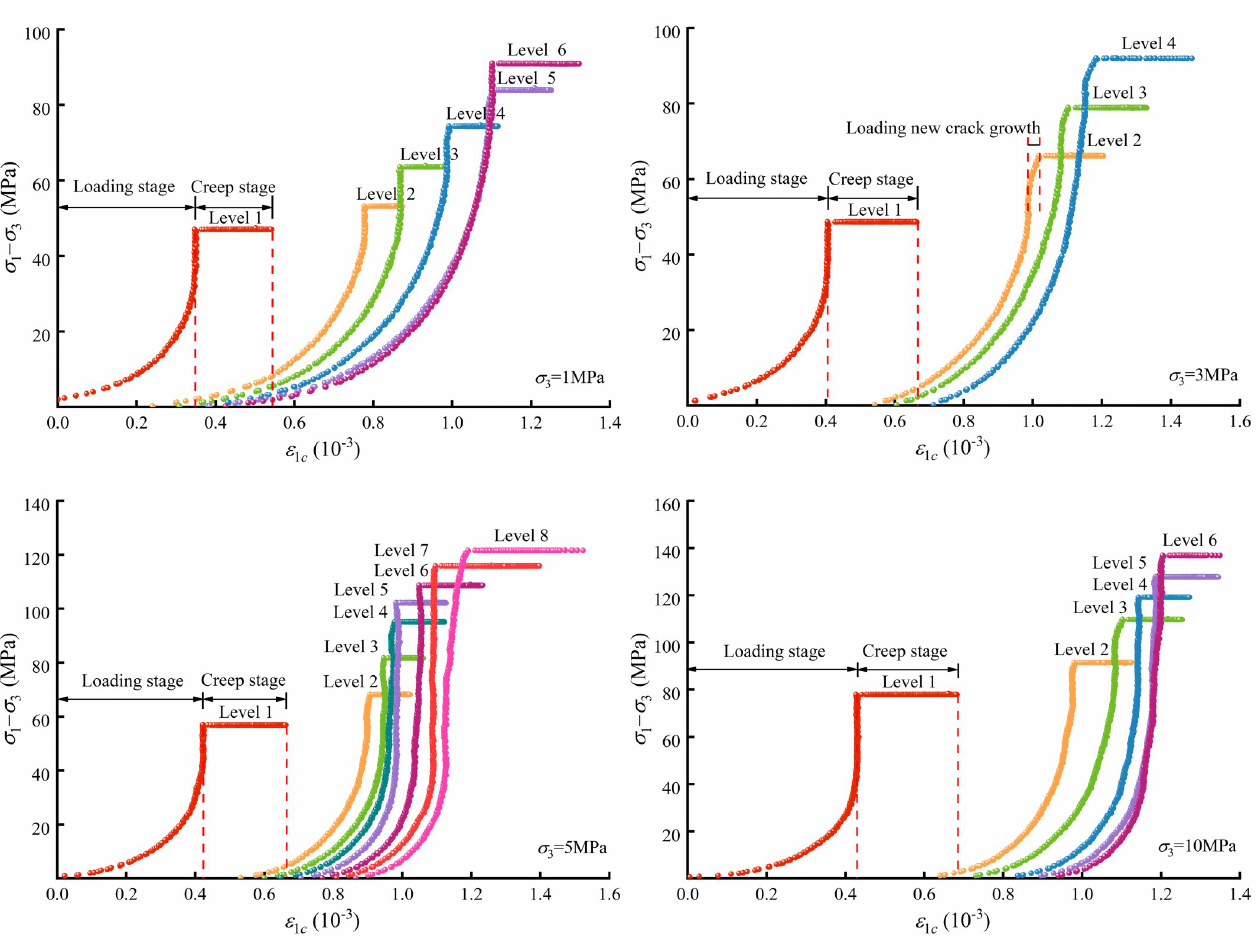
Fig 9. Axial crack strain results of micritic bioclastic limestone from triaxial compression creep tests.